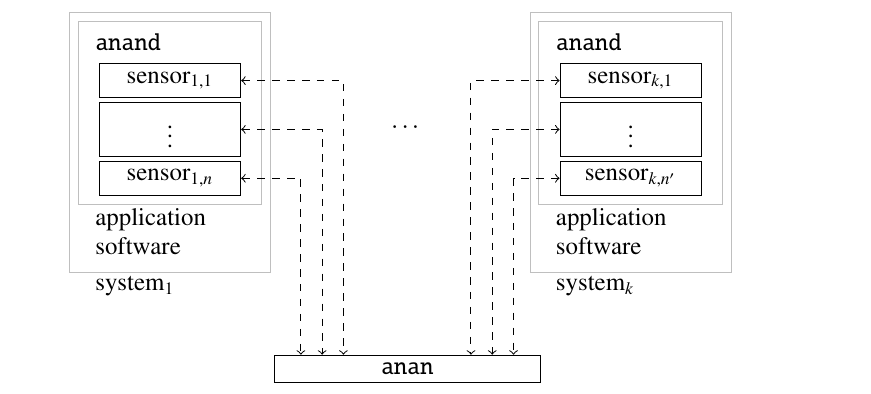
Figure 1. Overview of ANaN: Many systems run anand besides the main applications; each instance of anand executes a set of sensors; configurations and results are communicated to a central instance of anan